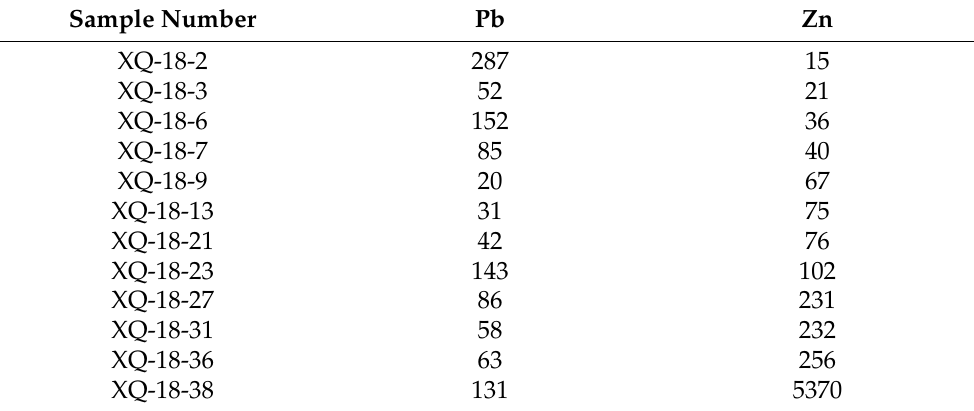
Table 4. Analytical results of ore-forming metal elements in bitumen from the Xuequ Pb–Zn mine (ppm) (according to Tan et al., 2021